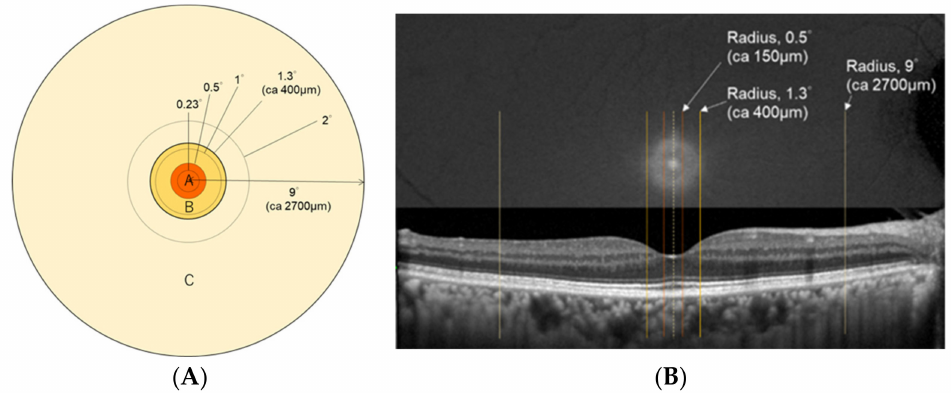
Figure 2. ( A ) Zone differentiation of MPOD measurement points. Zone A represents the area within a radius of 0.5 ◦ . Zone A contains mostly Z. Zone B represents a ring with radii of 0.5 ◦ and 1.3 ◦ . Zone B contains both Z and L. Zone C represents the area delimited by radii of 1.3 ◦ and 9 ◦ . Zone C contains mostly L. ( B ) Location of the three zones on macular pigment and OCT images. Images are from a 62-year-old-female, right eye. The central line indicates the center of the foveola. The following lines indicate the areas delimited by the mentioned radii, corresponding to each